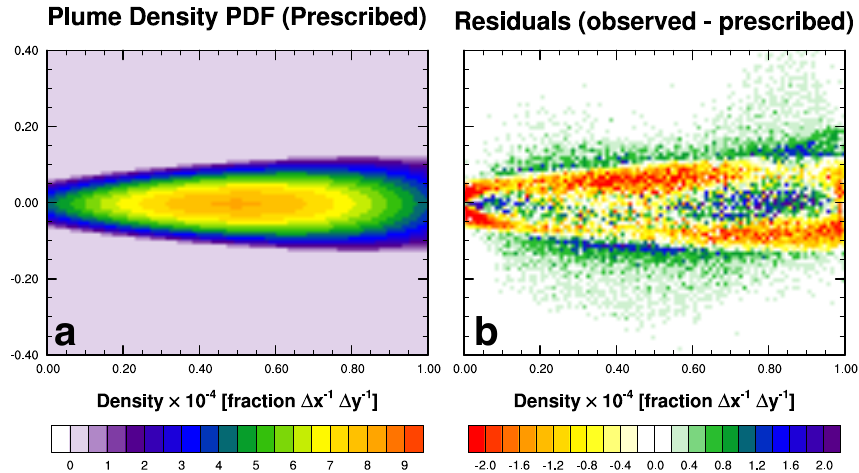
Fig. 9. (a) Best-fit parameterization of plume density. (b) Residuals computed as observed minus parameterized Eq. (11). Values are plotted in units of plume density, fraction per nondimensional unit of along-plume length and cross-plume width. Plume density, unlike plume fraction (Fig. 5), is normalized to sum to unity over the